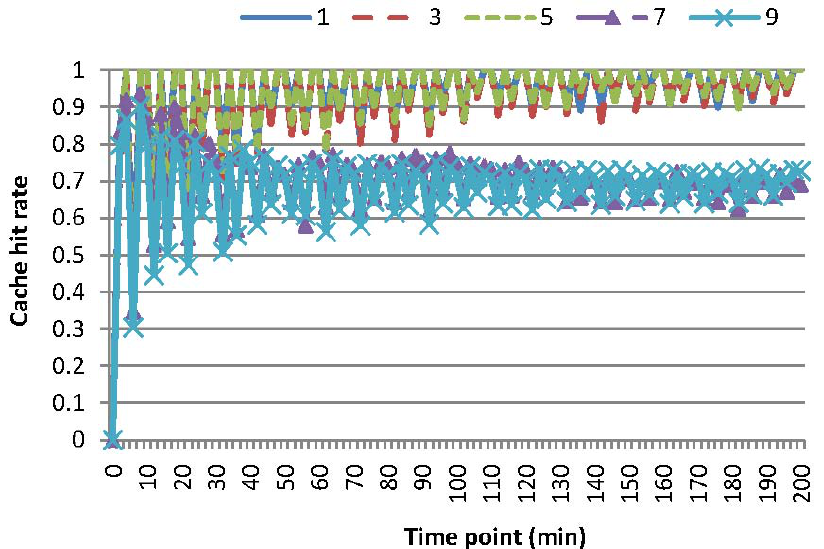
Figure 8. Comparison of cache hit rates for MAQWR, where the number of attributes are set to 1 , 3 , 5 , 7 and 9 , respectively. Similar to Figure 4, when the cache size of the SN is relatively small and is not capable of caching all sensory data requested by a certain query, the cache hit rates for sensory data cached in the SN decrease significantly (roughly from 95% down to